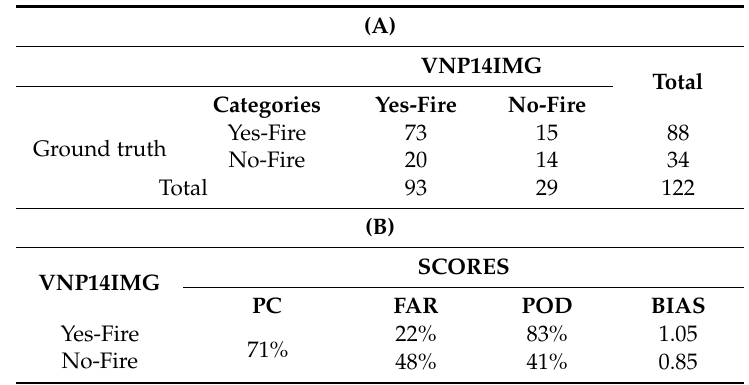
Table 7. (A) The results of the Contingency Table of VNP14IMG versus ground truth in Central Kalimantan and Riau Provinces (data in table show counts), and ( B ) the scores of PC, FAR, POD, and BIAS of VNP14IMG compared with ground truth data.